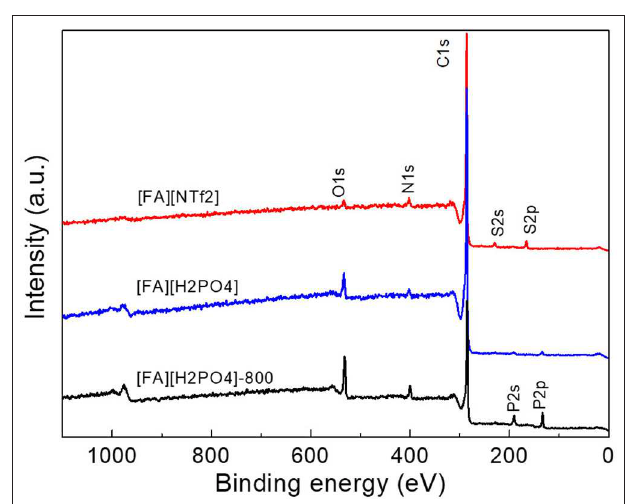
FIGURE 5 | Survey XPS spectra of carbons derived from